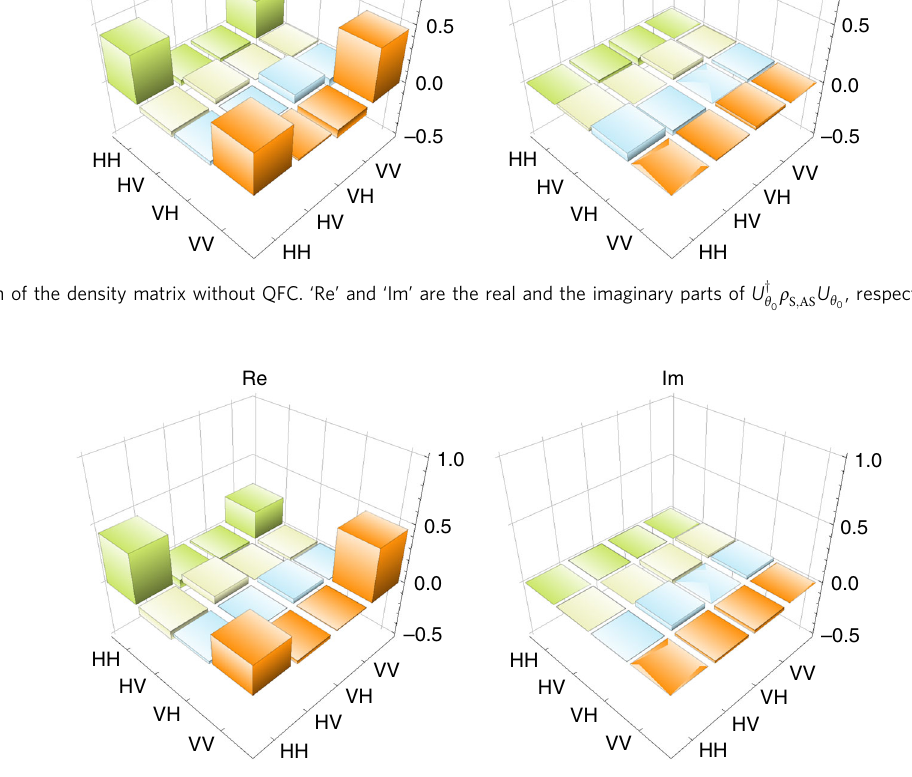
Fig. 4 Visualization of the density matrix with QFC. ‘ Re ’ and ‘ Im ’ are the real and the imaginary parts of U y θ